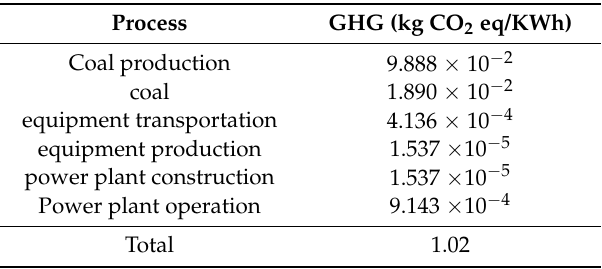
Table A1. Lifecycle greenhouse gas emissions of pulverized coal fired generation.